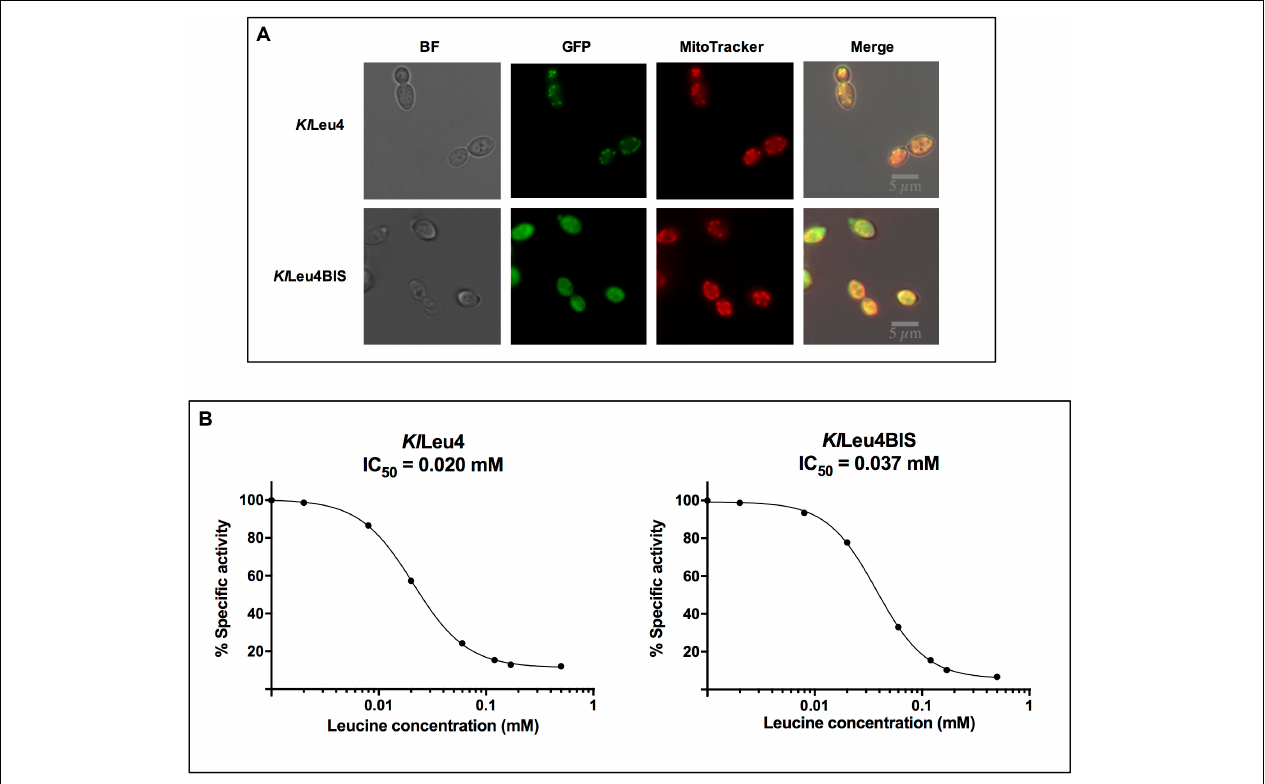
FIGURE 5 | Kl Leu4 and Kl Leu4BIS isozymes are leucine sensitive and respectively located in mitochondria and cytosol. (A) Isozyme leucine sensitivity was carried out on crude extracts as described in section “Materials and Methods.” Experiments were done in duplicate. (B) Subcellular localization of Kl Leu4 and Kl Leu4BIS paralogous proteins tagged with yECitrine using confocal microscopy. Strains were grown on minimal medium glucose (2%, w/v) and collected during exponential phase. Representative image of multiple cells from two biological replicates.